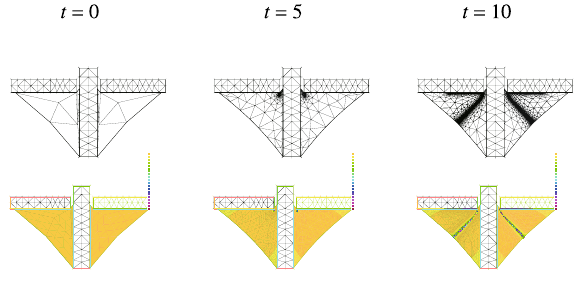
Fig. 15 Snapshots of cracking in solders with a volcano shape. Tem- poral evolution of meshing (upper) and temporal evolution of z (bottom) show crack propagation